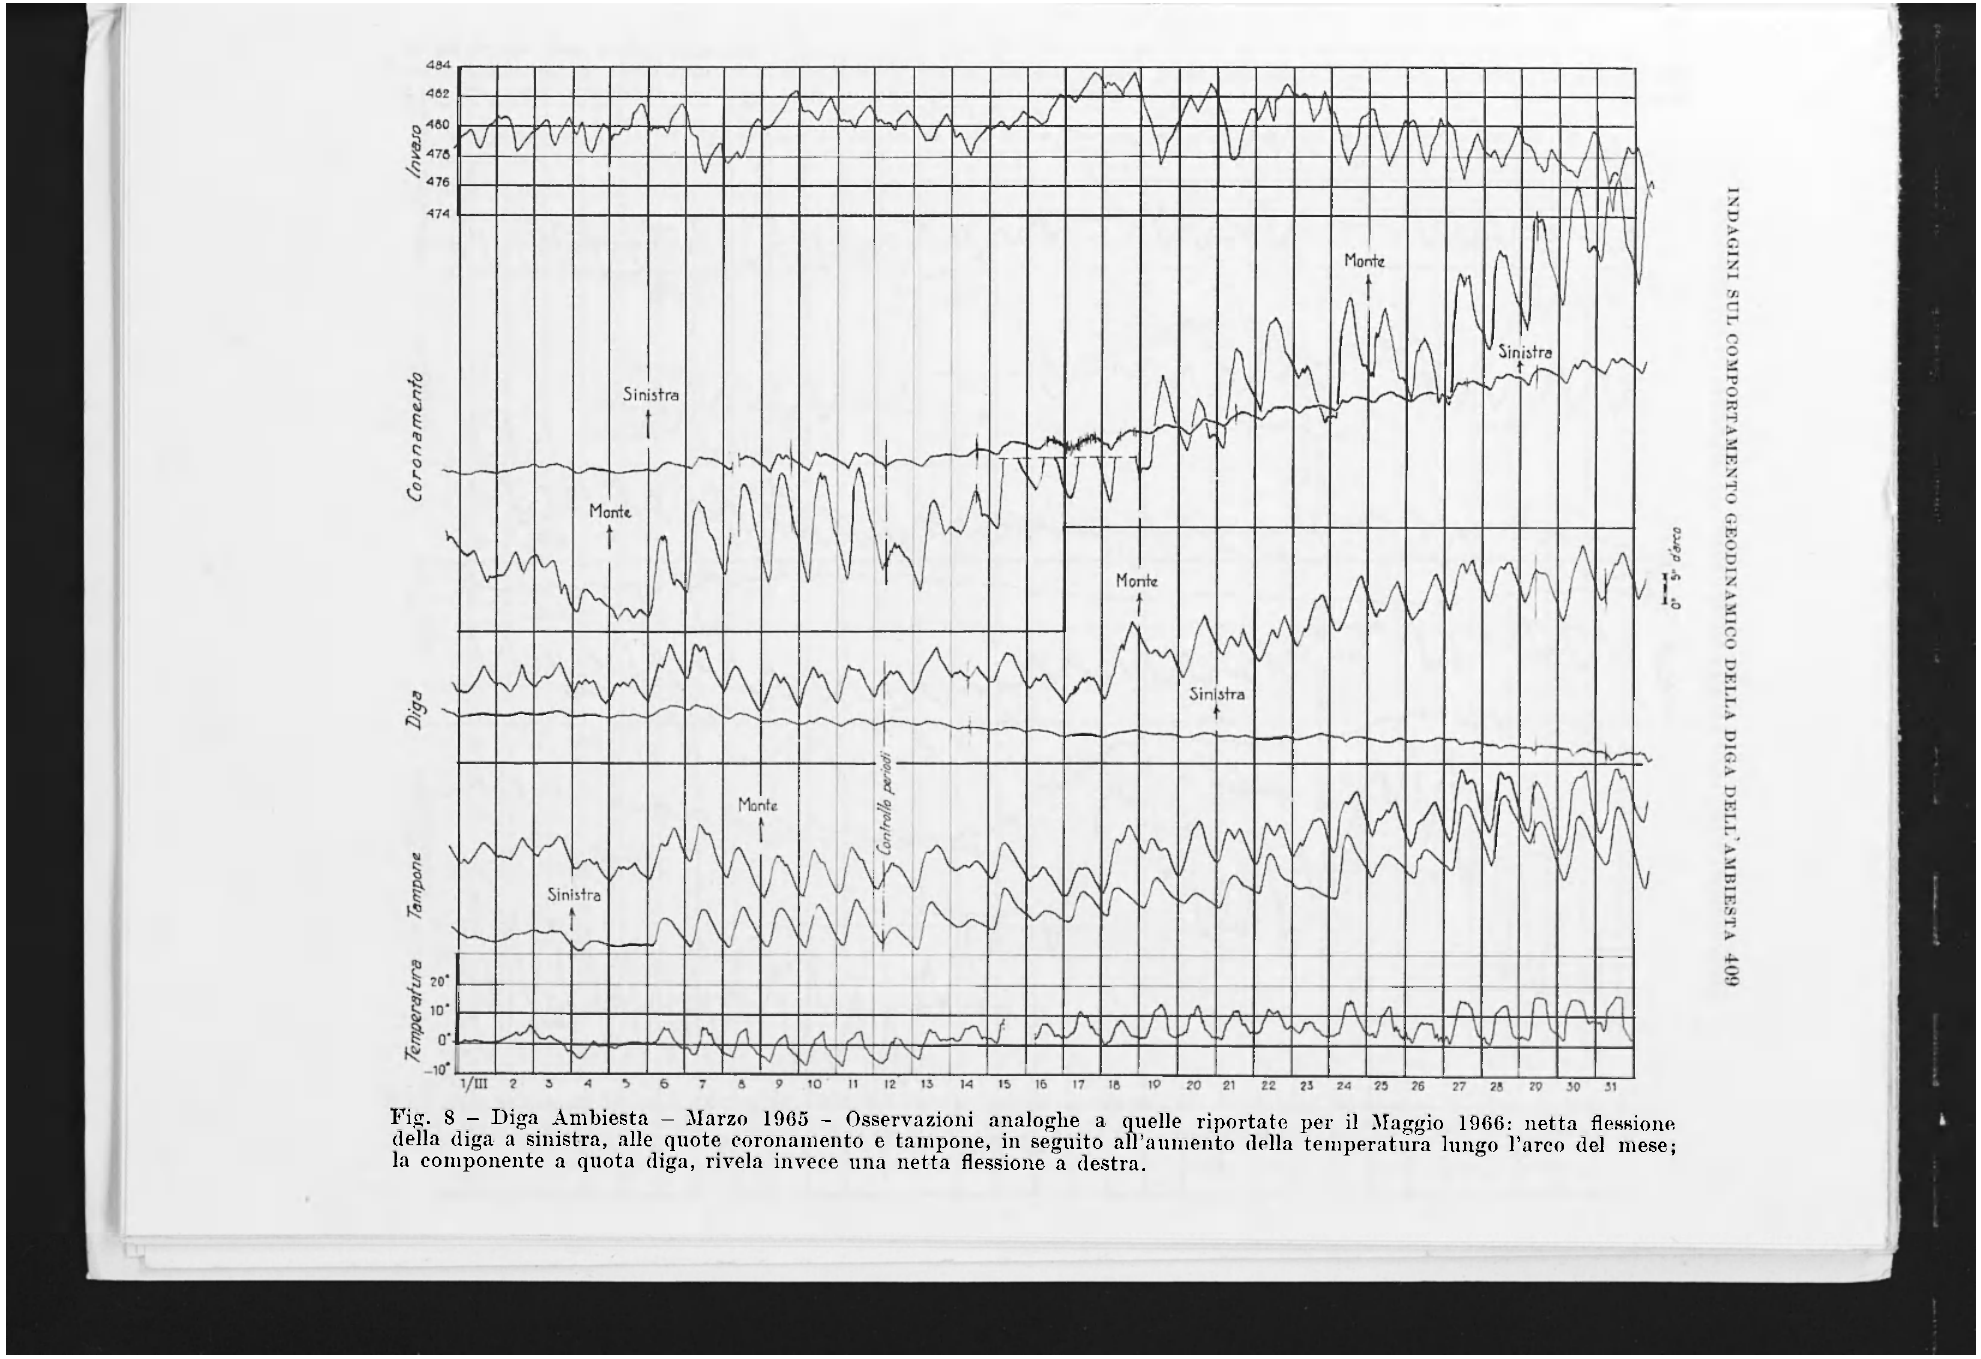
Fig. 8 - Diga Ambiesta - Marzo 1965 - Osservazioni analoghe a quelle riportate per il Maggio 1966: netta flessione della diga a sinistra, alle quote coronamento e tampone, in seguito all'aumento della temperatura lungo l'arco del mese; la componente a quota diga, rivela invece una netta flessione a